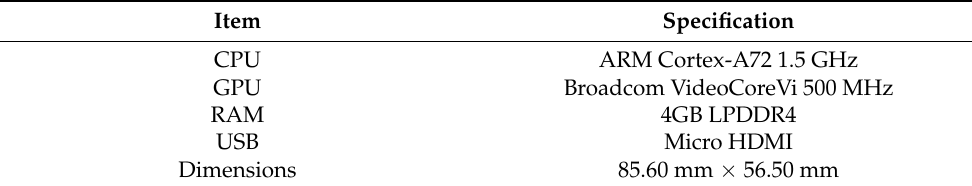
Table 3. Specification of Raspberry Pi 4 Model B.